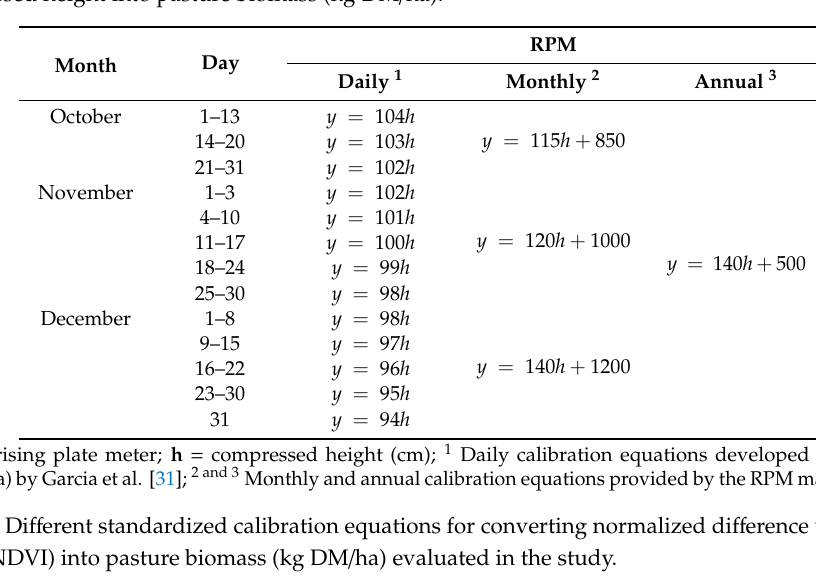
Table 3. Di ff erent standardized calibration equations for converting normalized di ff erence vegetation index (NDVI) into pasture biomass (kg DM / ha) evaluated in the study.